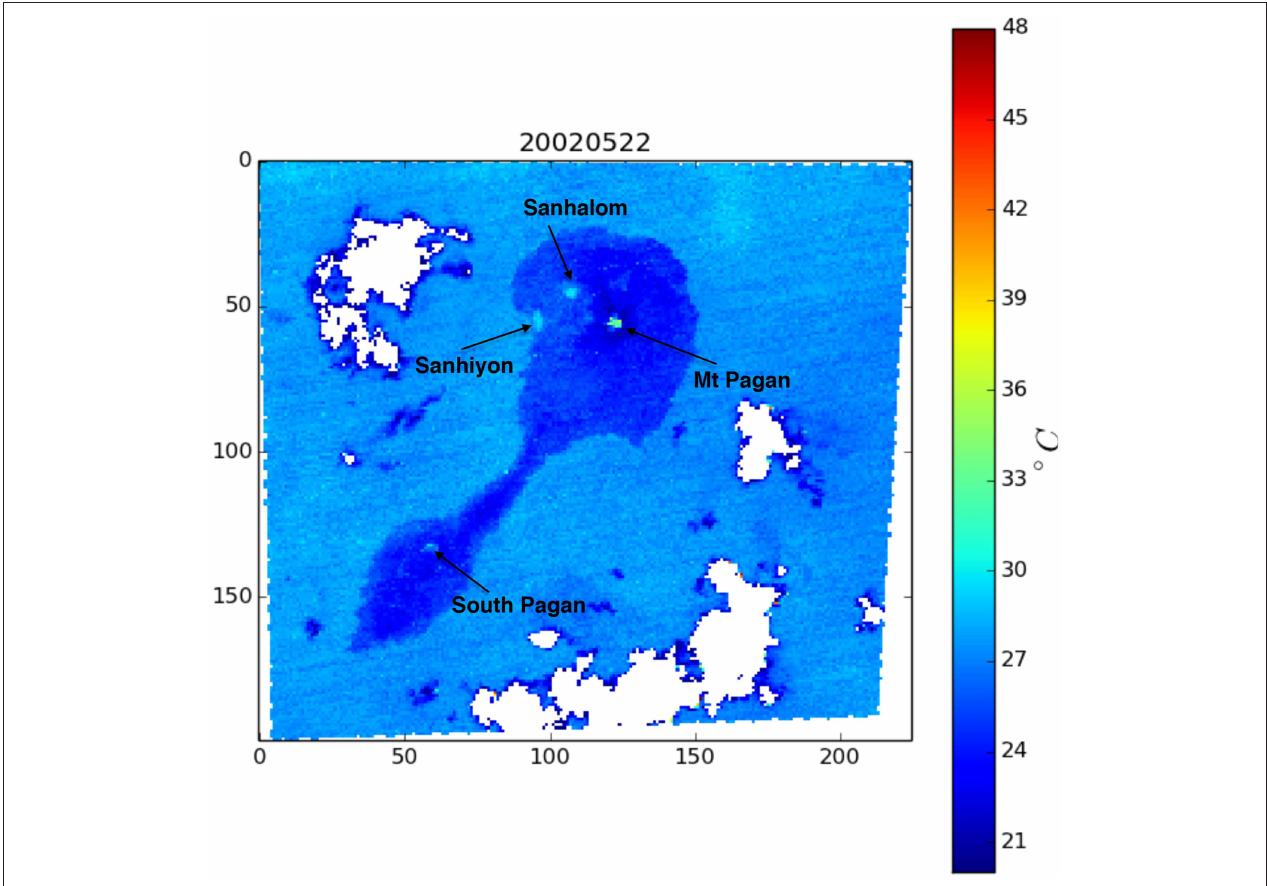
FIGURE 5 | ASTER Product 8 Image showing surface kinetic temperature over Pagan acquired on May 22, 2002. Four distinct thermal ‘hot spots’ on Pagan apparent in most ASTER scenes. Two are clearly correlated with lakes on the western side of the island (Laguna Sanhiyon and Laguna Sanhalom). The southern hotspot coincides with the oldest craters of South Pagan, Bulikan Bulifli, which is known to have mud pots and a solfatara field ( Trusdell, 2009). The main hotspot on the island is clearly correlated with emissions from the central vent of Mt.